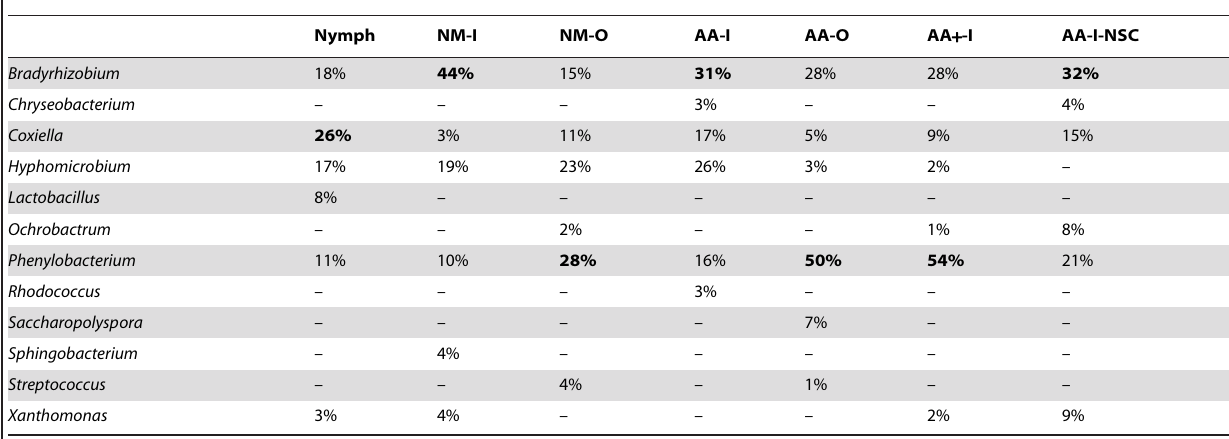
Table 4. Genus-level assignments of all sample